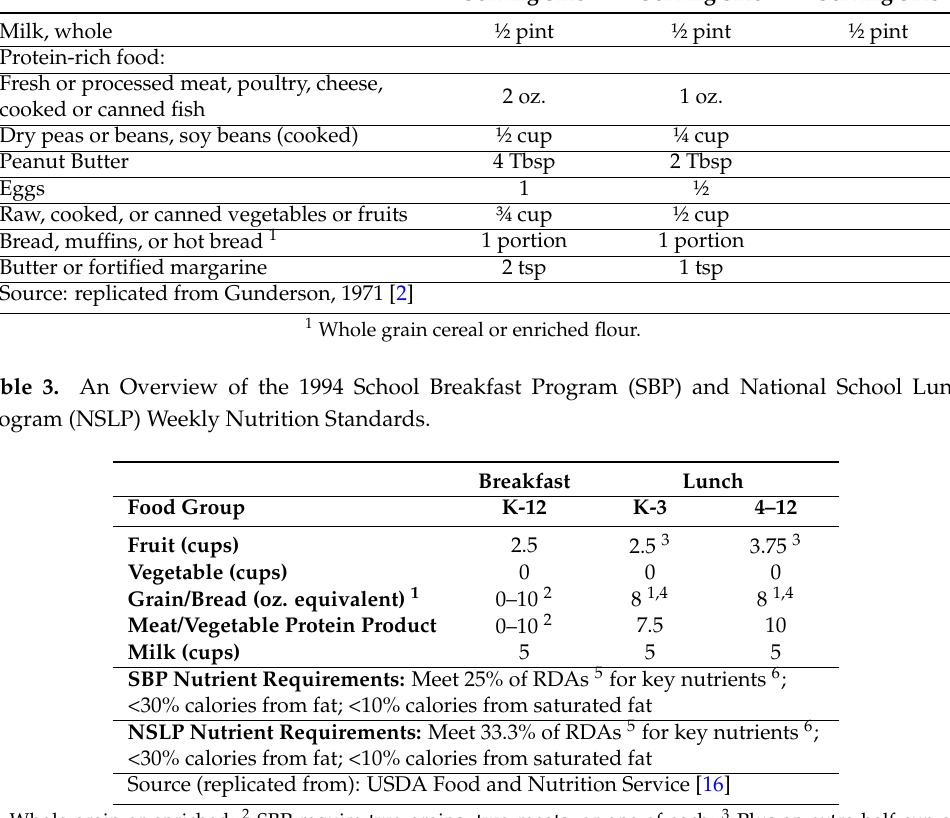
Figure 1. Historical Overview of the Policy and Programmatic Events that Occurred in the USDA National School Lunch Program (NSLP), School Breakfast Program (SBP), and Summer Food Service Program (SFSP) by Year. Table 2. The 1946 USDA National School Lunch Program (NSLP) Food ‐ Based Meal Patterns per Day. Food Group